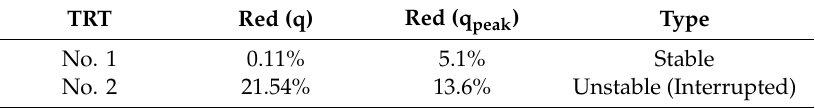
Table 2. The estimation of measuring uncertainty of two TRT